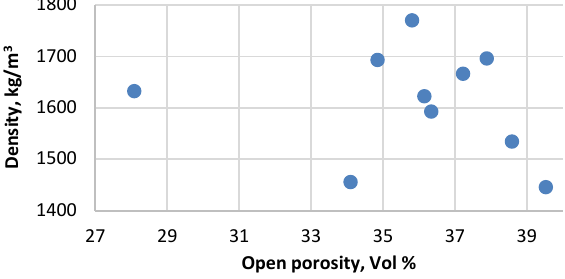
Fig. 3. Open porosity and density of tested historic